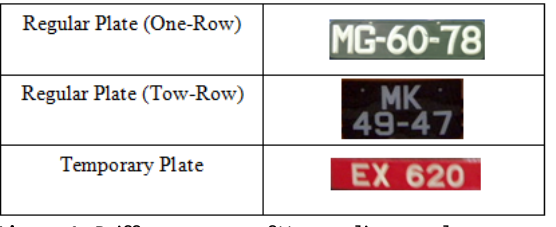
Figure 1: Different types of Macao license plates With this specification, the issues of the two types of variations can be summarized as follows: